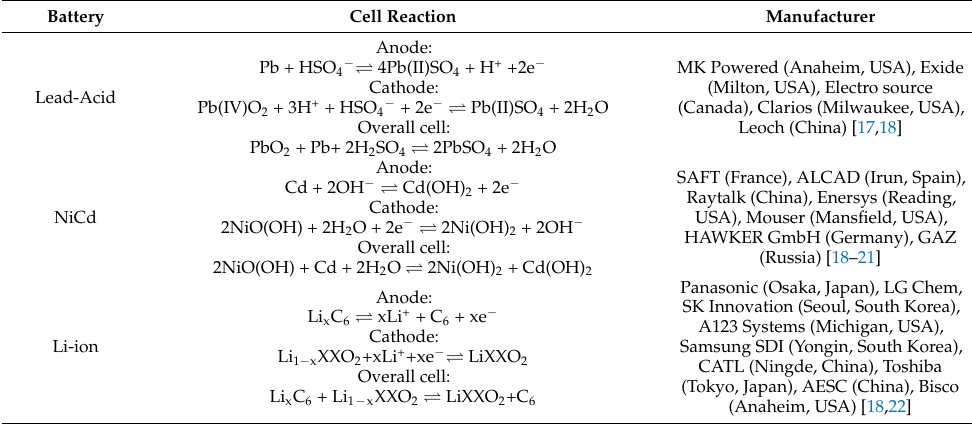
Table 2. Conventional batteries. Characteristics and Manufacturers. Battery Cell